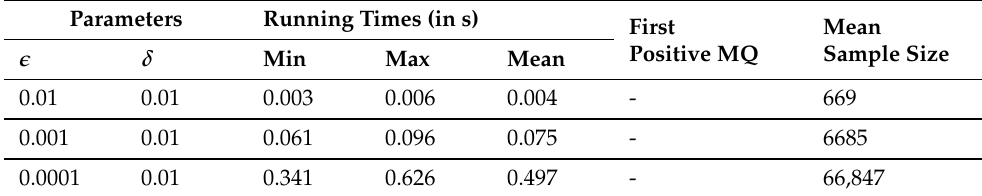
Table 6. Cruise controller: On-the-fly black-box checking.